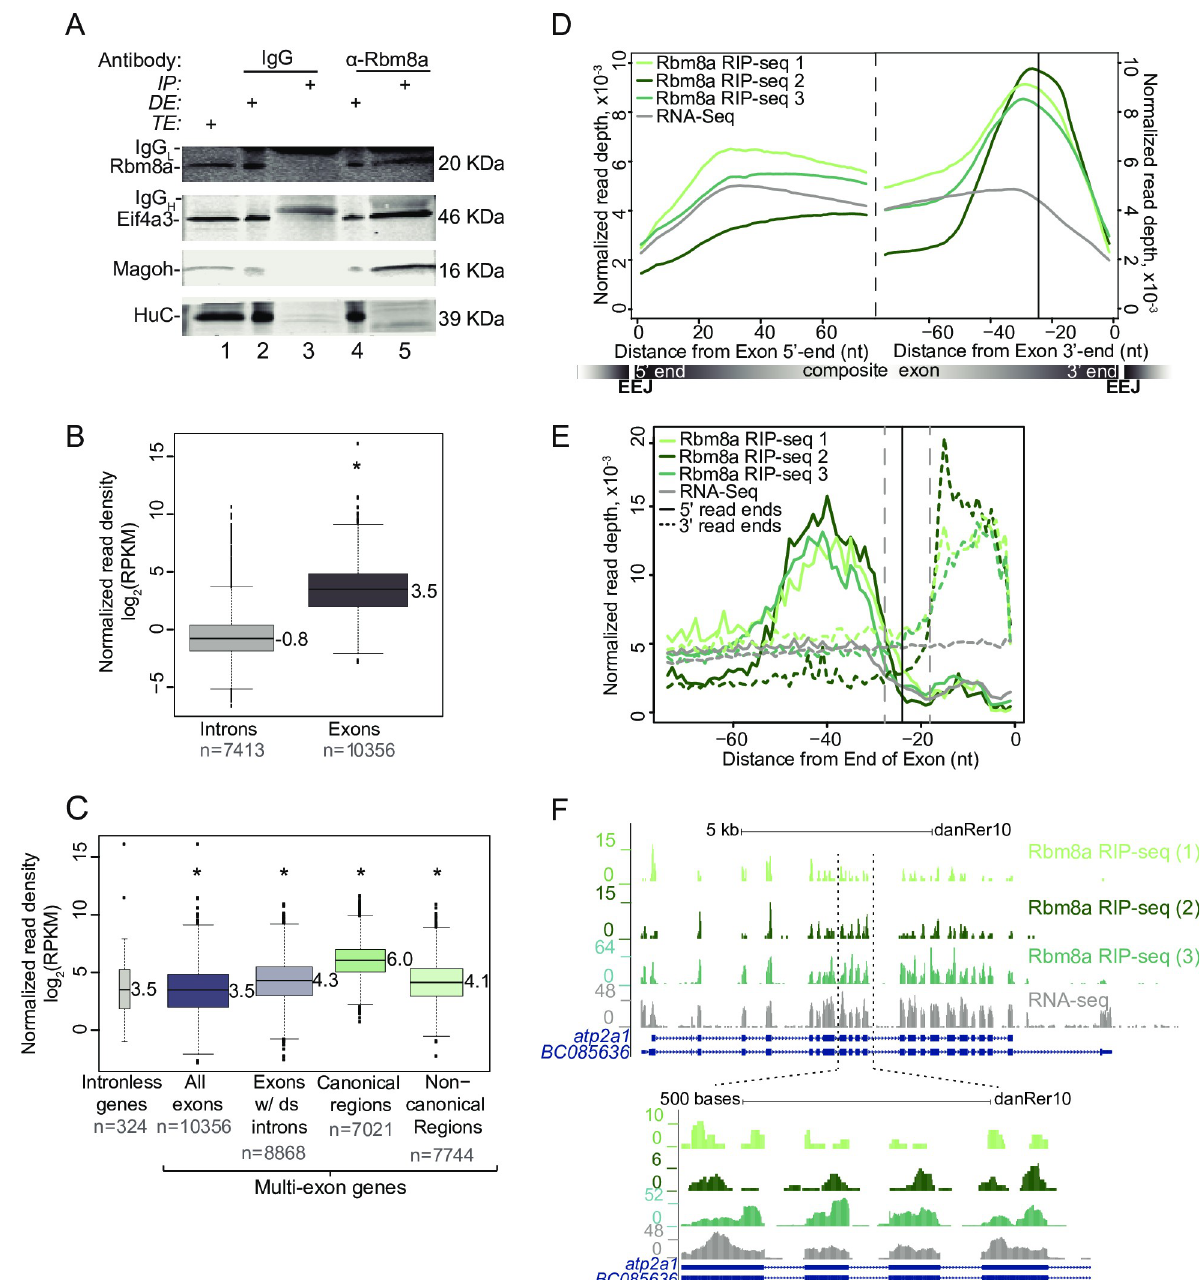
Fig 1. The zebrafish EJC is detected ~24 nucleotides upstream of exon-exon junctions. A. Western blot indicating Rbm8a, Eif4a3, Magoh and HuC proteins detected in RNase I-treated zebrafish embryo total extract (TE, lane 1), depleted extract (DE, lanes 2 and 4) immunoprecipitated protein complexes (IP, lanes 3 and 5). Antigens detected in the blot are listed on the left and antibodies used to immunoprecipitate complexes are listed on top. The signal corresponding to the antibody light chain and heavy chain in the IP lanes is indicated by IgG L and IgG H , respectively. B. Boxplots showing the Rbm8a RIP-Seq normalized read densities (reads per kilobase per million, RPKM) in intronic versus exonic genomic regions. Asterisk at the top indicates Wilcoxon test p-value, which is < 10 − 6 . C. Boxplots as in B showing the Rbm8a RIP-Seq normalized read densities (RPKM) in the indicated genomic regions (bottom). Exons with downstream introns include all but last exons. Asterisk at the top indicates Wilcoxon test p-values, which are < 10 − 6 . D. Meta-exon plots showing Rbm8a RIP-Seq and RNA-Seq (indicated on the top left) normalized read depths in a 75 nt region starting from the exon 5 0 (left of dashed black line) or 3 0 ends (right of dashed black line). Vertical black line: expected canonical EJC binding site (-24 nt) based on human studies. A composite exon with the relative position of exon-exon junctions (EEJ) is diagrammed at the bottom. E. A meta-exon plot of start and end of Rbm8a RIP-Seq or RNA-Seq reads (indicated on the top left; 5 0 ends, solid lines; 3 0 ends, dotted lines). Vertical black line: canonical EJC site (-24 nt). Gray vertical dashed lines represent boundaries of the minimal EJC occupied